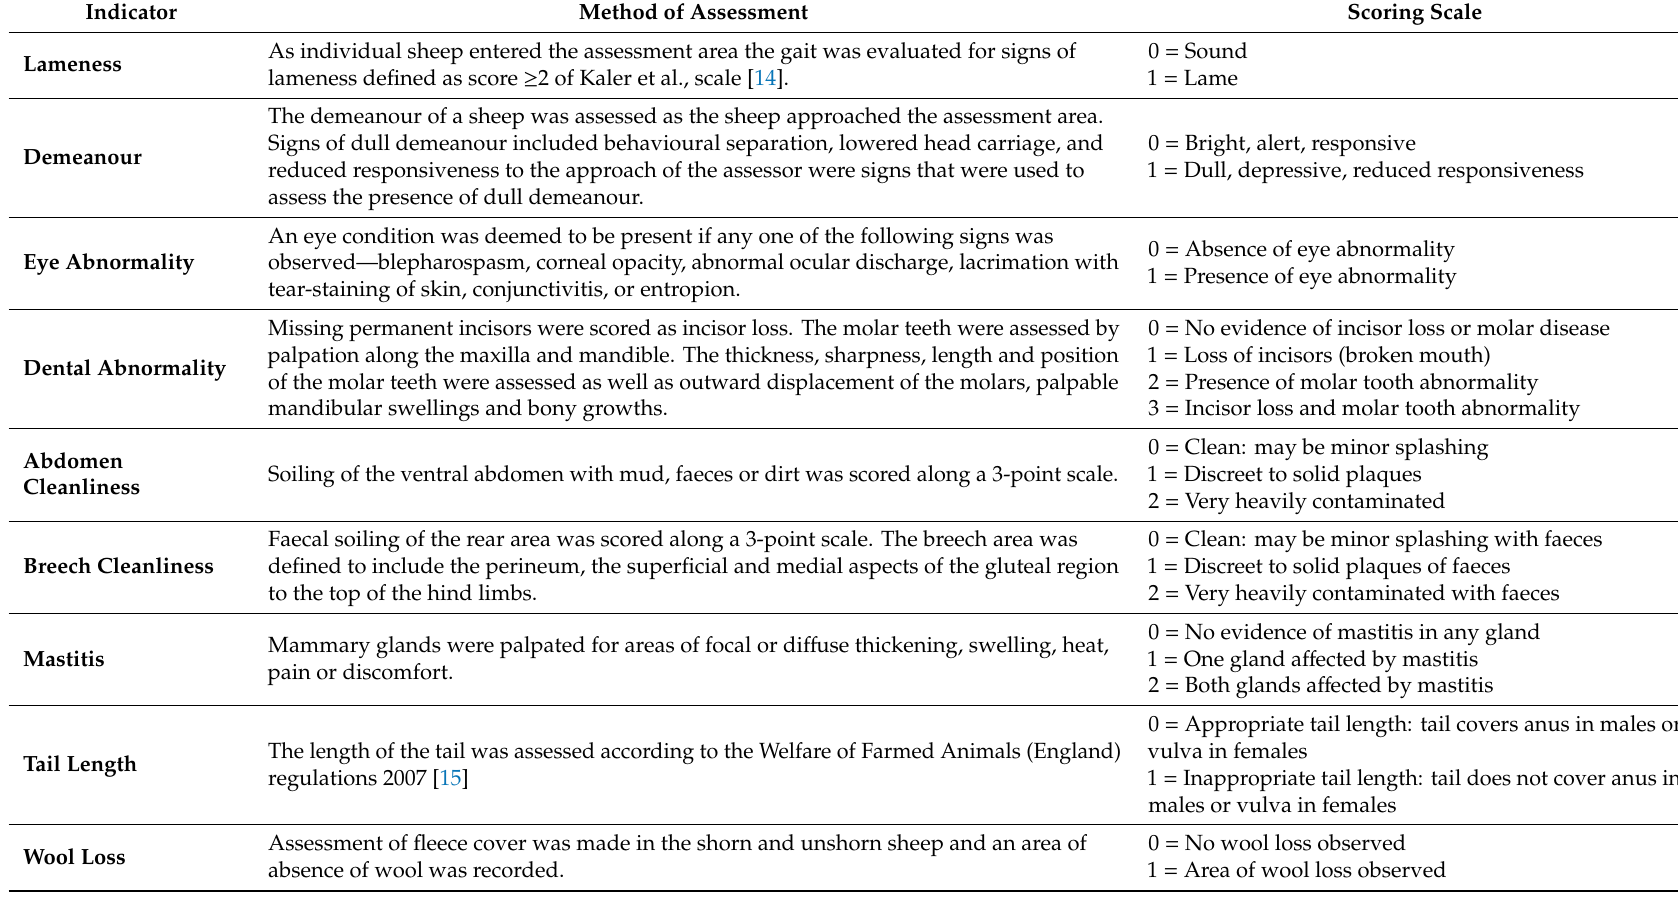
Table 2. Description of indicators and scoring